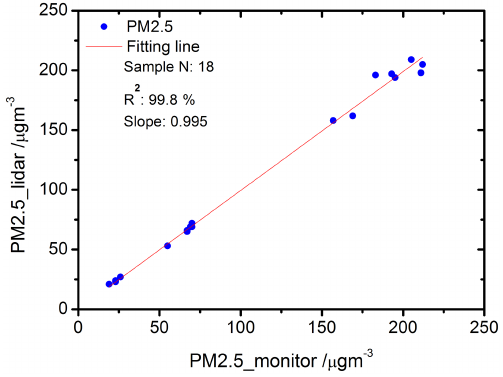
Figure 6. Comparison of surface PM 2 . 5 obtained by PM 2 . 5 Monitor and